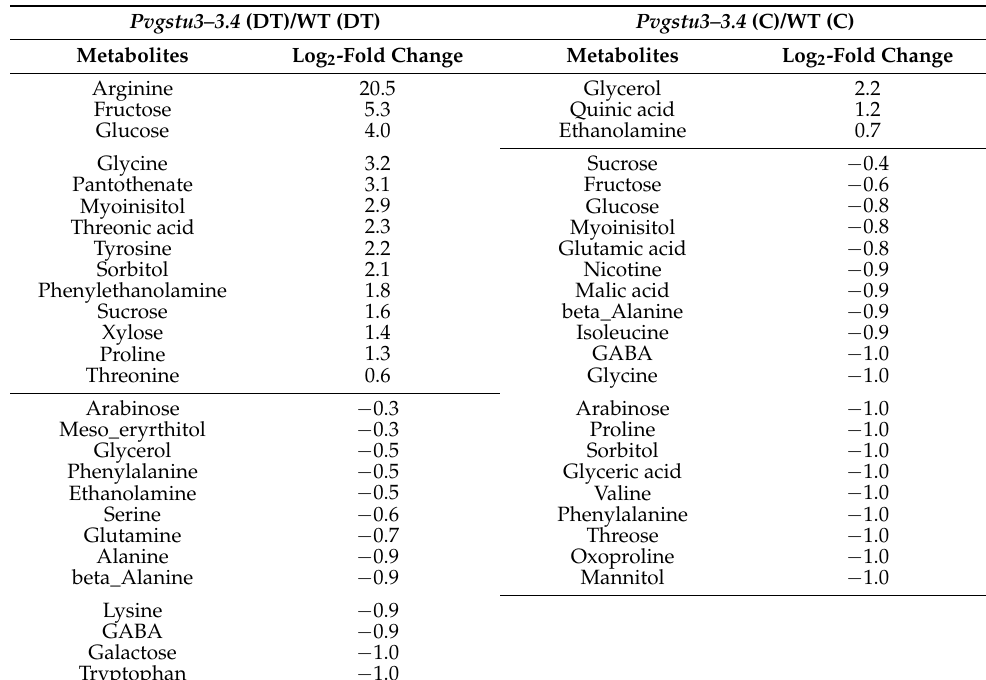
Table 5. Metabolites that were significantly ( p < 0.05) altered in the different genotypes under combined drought and heat stress and control conditions. Positive values indicate fold-increase, whereas negative values fold-decrease.